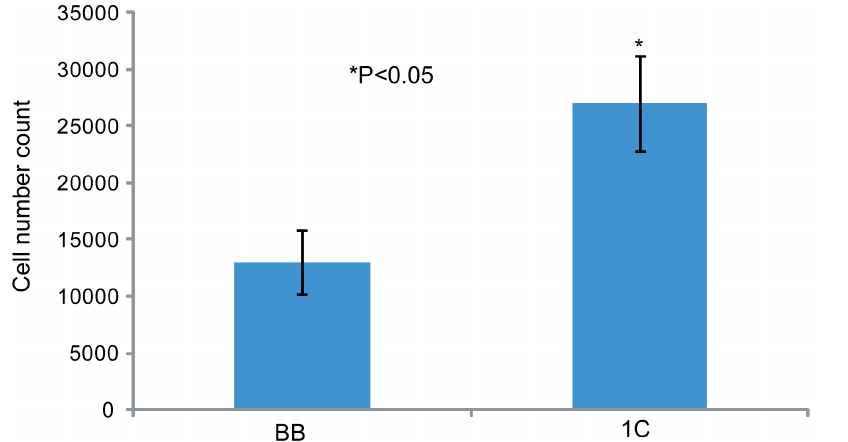
Figure 1. RASSF1C stimulates lung cancer cell proliferation. NCI-H1299 cells stably transduced with MLV-backbone (BB) or MLV-HA-RASSF1C (1C) were treated with 1 m g/ml doxycycline for 72 h, and then cells were counted. RASSF1C over-expression (1C) increased cell proliferation by 2.5 fold compared to control (BB). Data is representative of at least 3 independent experiments, and the values represent the mean 6 SEM. * P , 0.05.